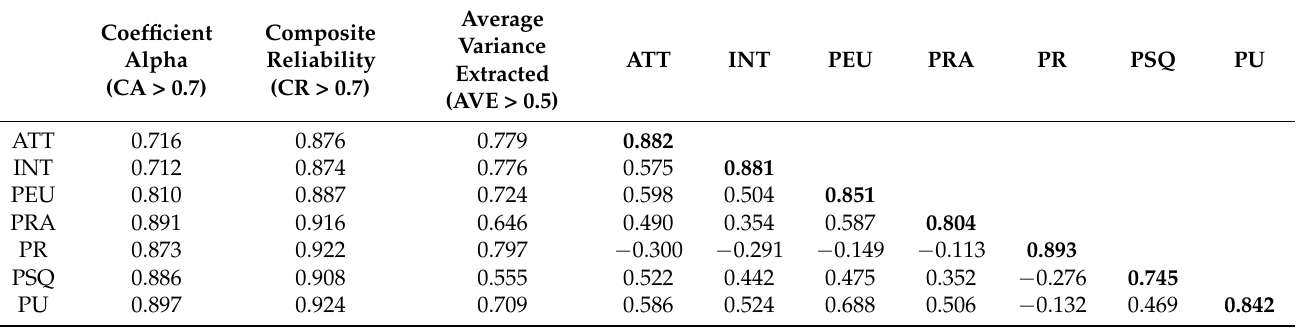
Table 5. Construct reliability and validity results (CA, CR, AVE, and inter-construct correlations).